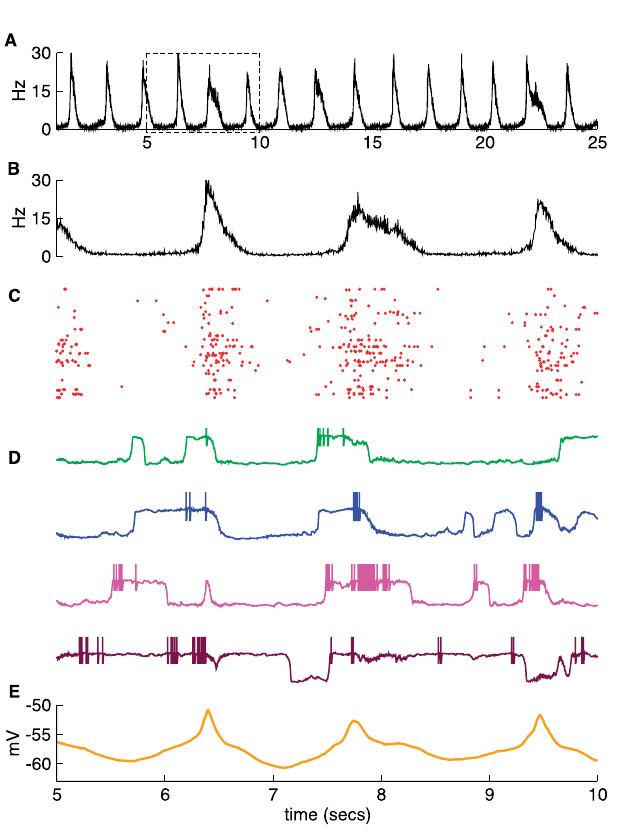
Figure 2. A regular network . (A) Population rate over 25seconds; the other traces correspond to the time interval from t=5 to t=10seconds (box). (B) Expanded population rate. (C) Rastergram (100 neurons). (D) Membrane potential of 4 neurons. (E) Average membrane potential. The mean rate in the